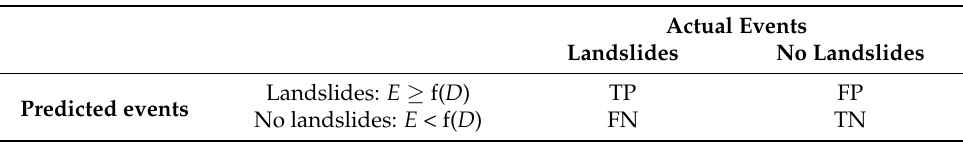
Table 2. Contingency matrix defined for comparing the actual and predicted events based on a defined threshold E = f( D